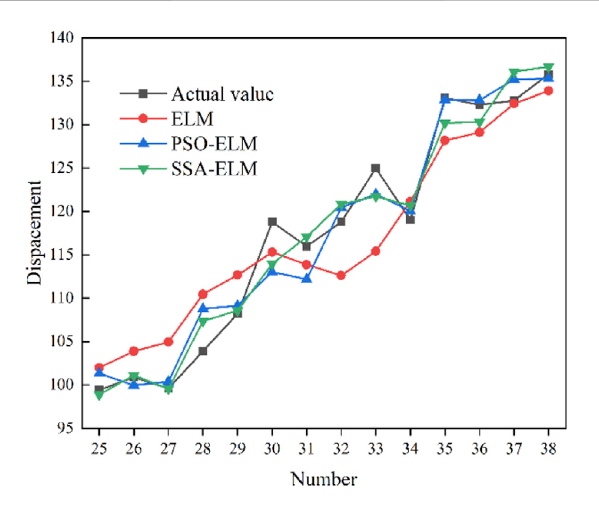
FIGURE 3 Fitness optimization graph.